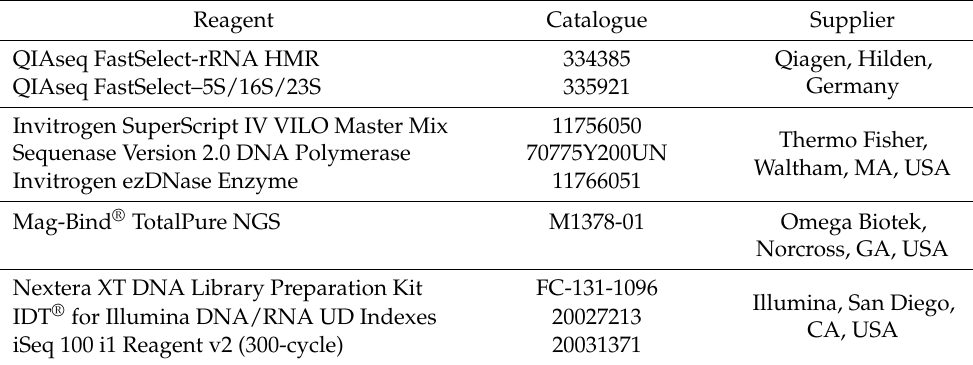
Table 1. Reagents used for RAPID prep